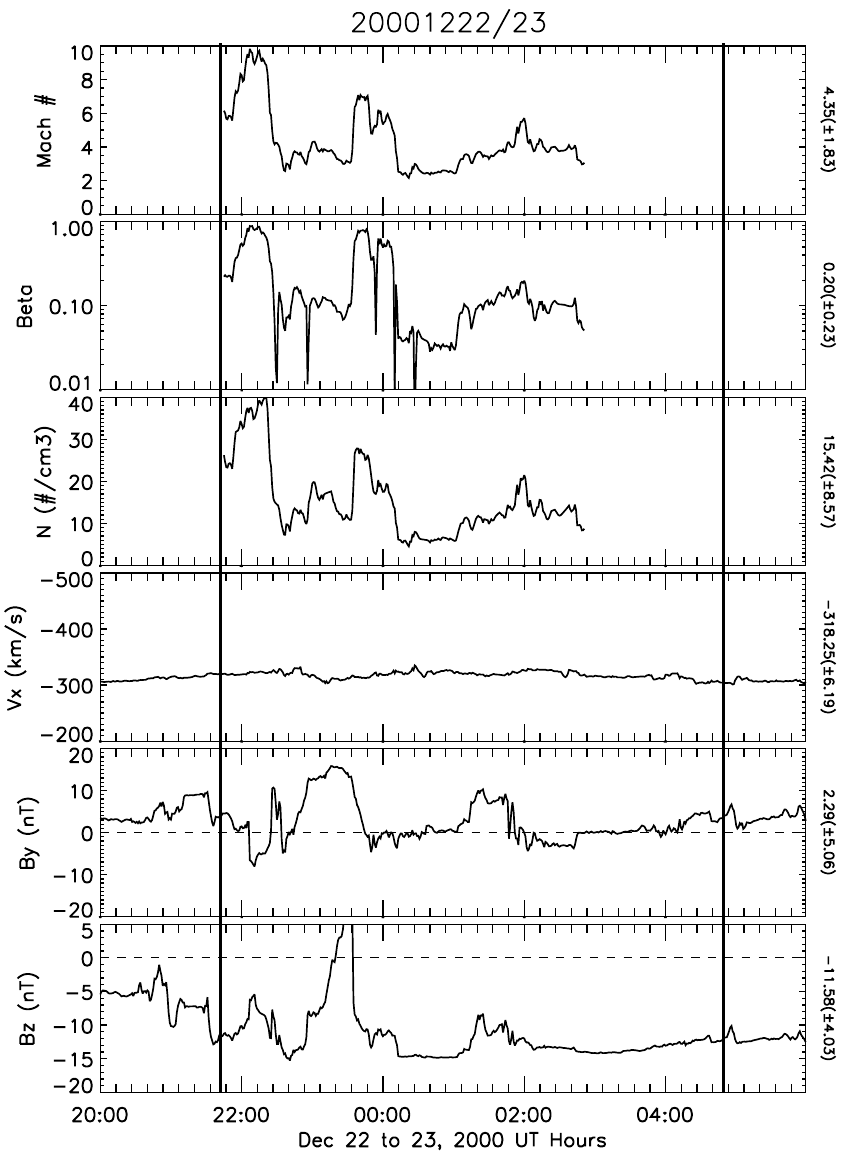
Fig. 7. Propagated ACE data for the BRI on 22 and 23 December 2000 (Event 3). The set up is the same as Figs. 3 and 5.